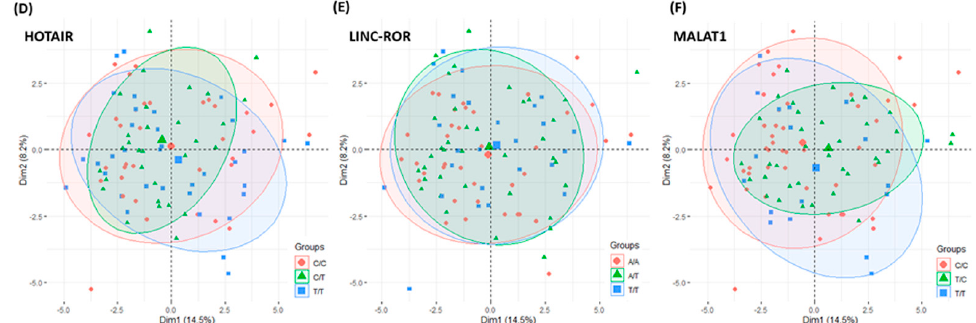
Figure 3. Impact of variant on disease activity index. ( A – C ) Box plots in SLE with and without nephritis show no significant difference in SLE disease activity index (SLEDAI). ( D – F ) The principal component analysis for data exploration showed no clear demarcation between patients with different genotypes. p -values ≤ 0.05 were considered statistically significant.